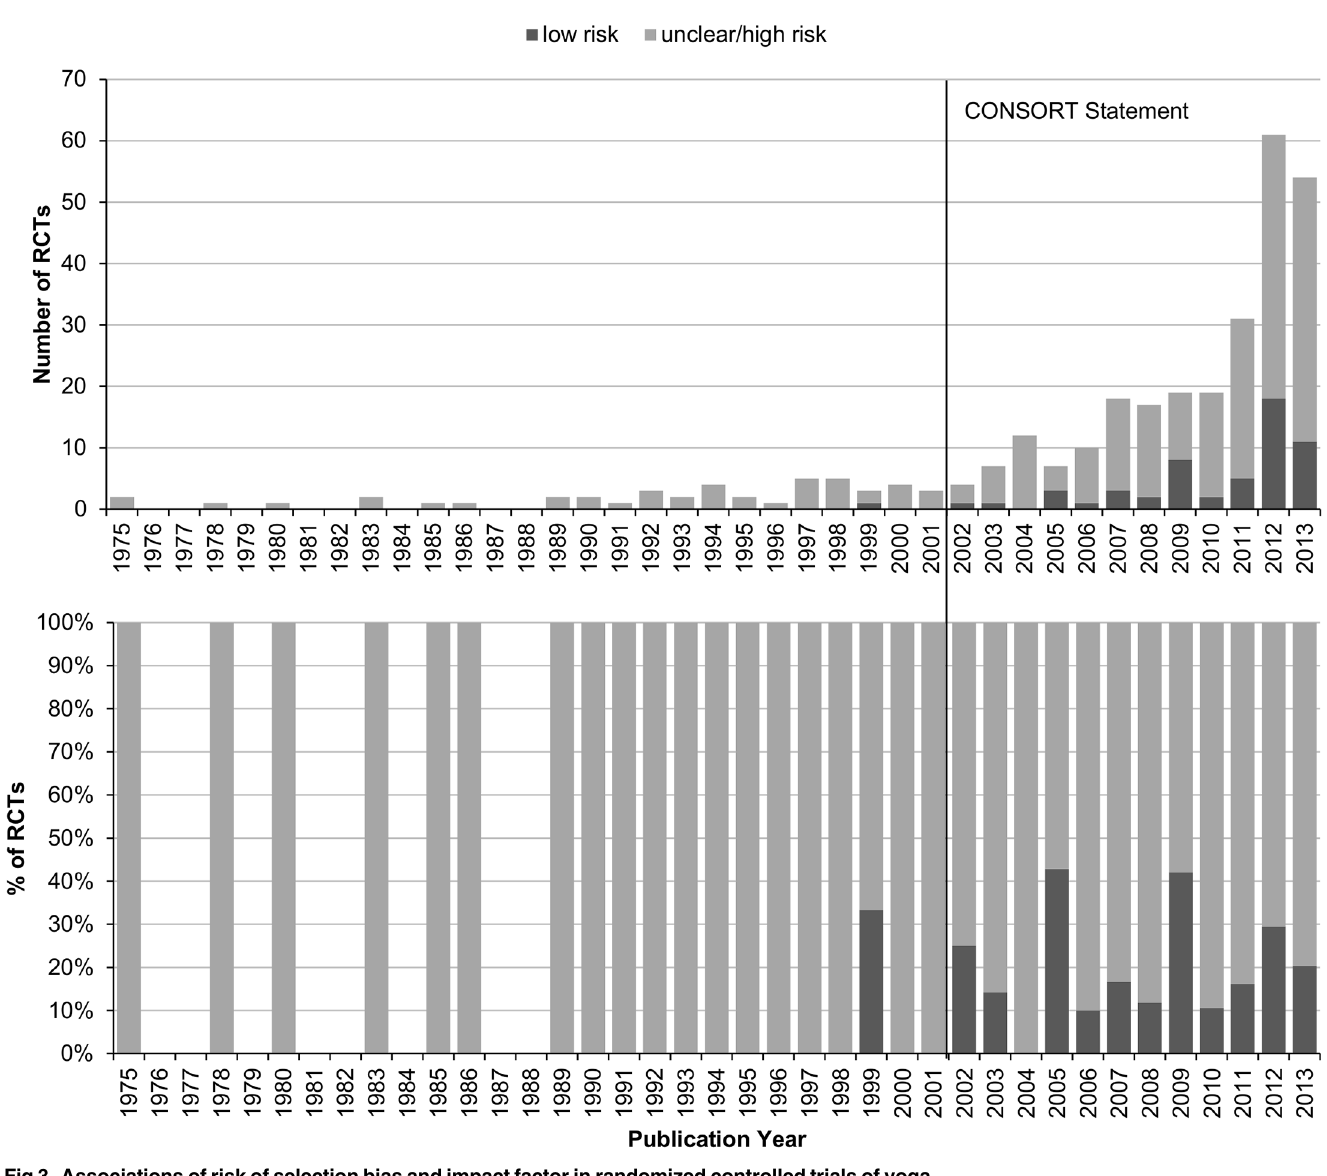
Fig 3. Associations of risk of selection bias and impact factor in randomized controlled trials of yoga.